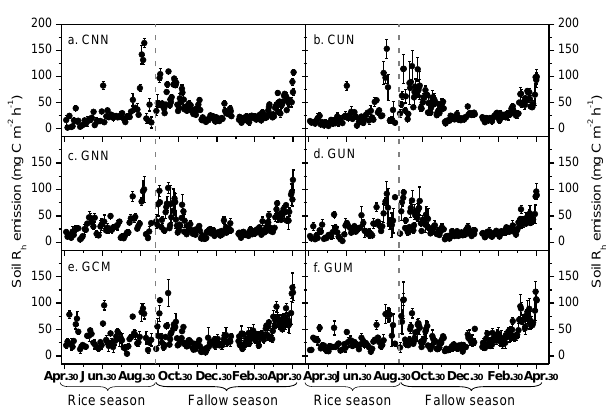
Figure 6. Seasonal dynamics in (a–f) soil heterotrophic respiration ( R h ) emissions (mean ± standard error) from bare soils of differ- ent fertilizer treatments in the conventional paddy and ground cover rice production systems during the rice–fallow rotation cycle of 2011–2012. Definitions of abbreviations for the different fertilizer treatments are shown in the footnotes of Table 1 and in the